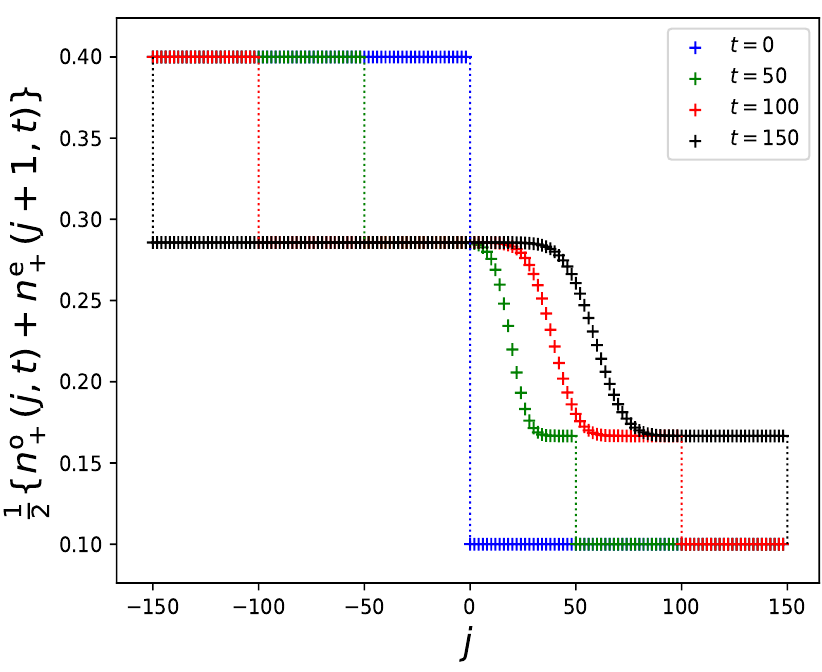
Figure 3: Density profile at different times. The values of the parameters are α = 0.4, α = 0.3, β = 0.1, β = 0.2. We observe two discontinuities propa- + − + − gating at velocities − 1 and 1 respectively (borders of the propagation cone) and a diffusive smoothing of the domain wall on the ray j =